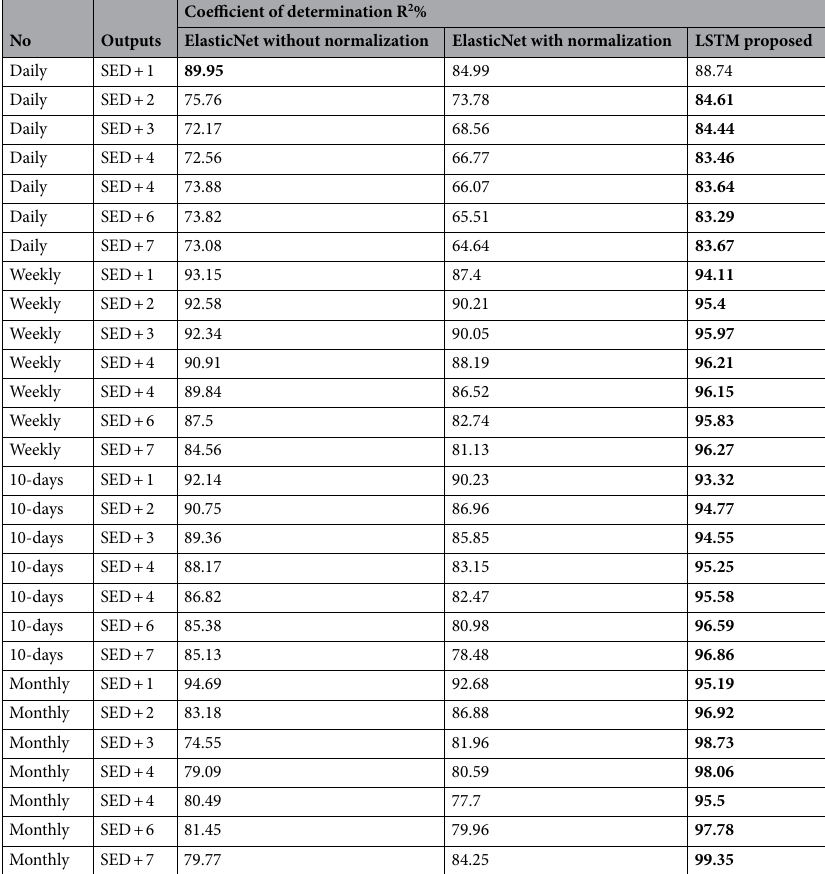
Table 4. Coefficient of determination for the four scenarios four two models to predict from one to seven days ElasticNet LR and produced better forecasting results in all scenarios. Figure 13 illustrates the R 2 for Elastic Net L.R. and LSTM in various time steps ahead. SED + 1 for all scenarios shows that the model fits the data better than the next week of sediment (SED + 2) until SED + 7. The results indicate that LSTM can be used to predict the expected changes in sediment one week ahead. Figure 14 visualizes absolute error (A.E.) distribution to evaluate the proposed prediction model by calculat- ing the frequency of absolute errors in four scenarios. It is evident that the points are gathered around low values of error with high frequencies. The absolute errors in the monthly scenario have values under 5. To visually explore how R 2 values represent the scatter around the regression line, Figs. 15, 16, and 17 plot the fitted values by observed values. The scatter plots of the proposed LSTM model were shown in Fig. 15. The figure illustrates the scatter plot of actual sediment versus forecasted sediment for four scenarios: daily, weekly, 10 days, and monthly. In addition, the signals of actual and forecasted sediment were shown in this figure. It was evident that there is a big match between the actual and forecasted sediment in all scenarios and specifically the monthly one. Having two parameters result in three scenarios for input sensitivity study. These three scenarios aim to study the impact of inputs on the learning model. In this experiment, it was found that using both history of discharge and sediment can improve the evaluation metrics compared to using only one input. Additionally, discharge input with its histories plays a significant role in predicting SSL. On the contrary, utilizing only previ- ous historical data of sediment is not enough and not efficient to predict future sediment. In Figs. 16 and 17, using both sediment and discharge as inputs leads to better matching between actual sediment and forecasted sediment than using sediment discharge only. For the weekly scenario, using sediment only gives the worst fit of the two models. On the other hand, using discharge only in both models can give a good fit but less than using both sediment and discharge. Table 5 shows the impact of two factors: alpha and in ElasticNet LR. The coefficient of determination was calculated for various values of alpha and l 1 _ratio. It was found that when alpha = 0.1 and l1_ratio = 1, R 2 has the best value of 94.09%.